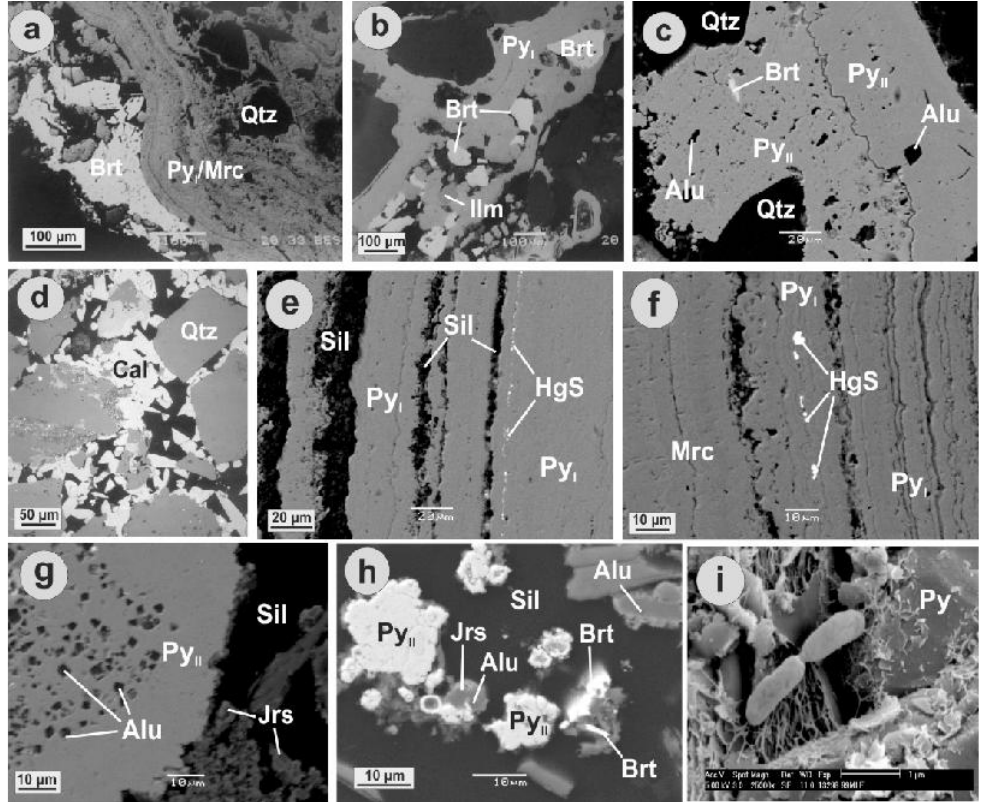
Figure 6. Backscattered ( a – h ) and secondary ( i ) electron images of sulfide edifices from Paleochori Bay (samples as in Tables 1 and 2): ( a ) hydrothermal barite (Brt) surrounding colloform pyrite/marcasite (Py I/Mrc), and detrital quartz (Qtz) grains (ML03); ( b ) colloform pyrite (Py I) surrounding and cementing barite (Brt) and ilmenite (Ilm) (ML03); ( c ) detrital quartz surrounded by massive pyrite (Py II) hosting alunite (Alu) and barite (ML04); ( d ) detrital quartz cemented by hydrothermal Mn‐rich calcite (Cal) (ML28C); ( e , f ) cinnabar (HgS) microlayers within colloform pyrite/marcasite (Py I) alternating with bands of amorphous silica (Sil) (ML03); ( g ) natrojarosite (Jrs) surrounding pyrite (Py II) hosting pseudocubic grains of alunite (ML05); ( h ) subhedral and minor framboidal pyrite associated with barite, amorphous silica, alunite, and natrojarosite (ML04); and ( i ) microbial cells showing division (implying active growth), attached to pyrite. Honeycomb organic structures are in between pyrite and microbes (ML27C).